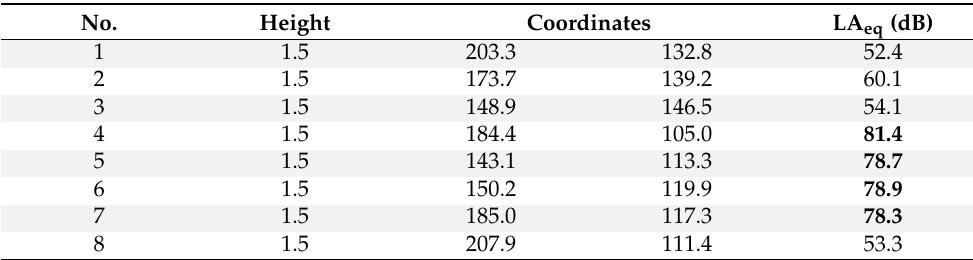
Table 4. Table of calculated values of measured points for demolition work with the simultaneous deployment of machines.